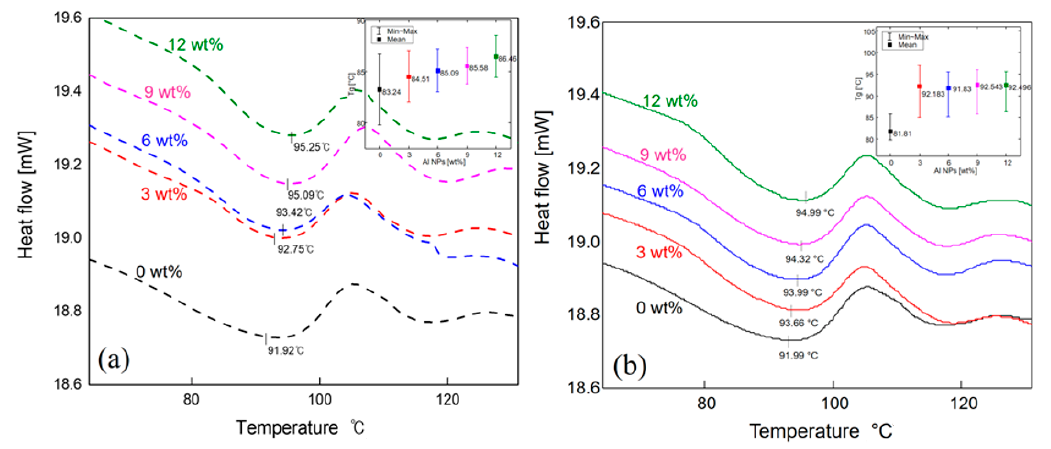
Figure 3. DSC of ABS/Al ( a ) 20 nm and ( b ) 40 nm nanoparticle composites.